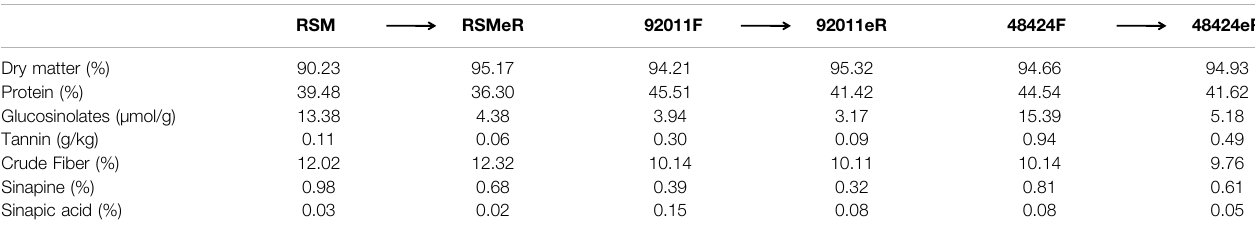
TABLE 1 | Effects of fungal pretreatment and antioxidant extraction on the composition of RSM. RSM RSMeR Dry matter